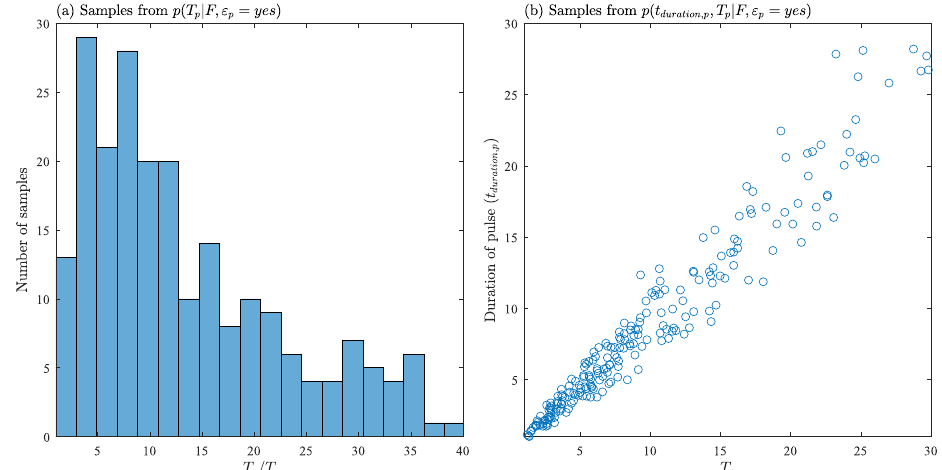
Figure 18. ( a ) Samples for ratio of pulse period to fundamental period of structure conditional on failure and ε p = yes (i.e., samples from p ( T p | F , ε p = yes ) ). ( b ) Samples for pulse period and pulse duration conditional on failure and ε p = yes (i.e., samples from p ( T p , t duration , p | F , ε p = yes ) ). Both are for the cross-braced